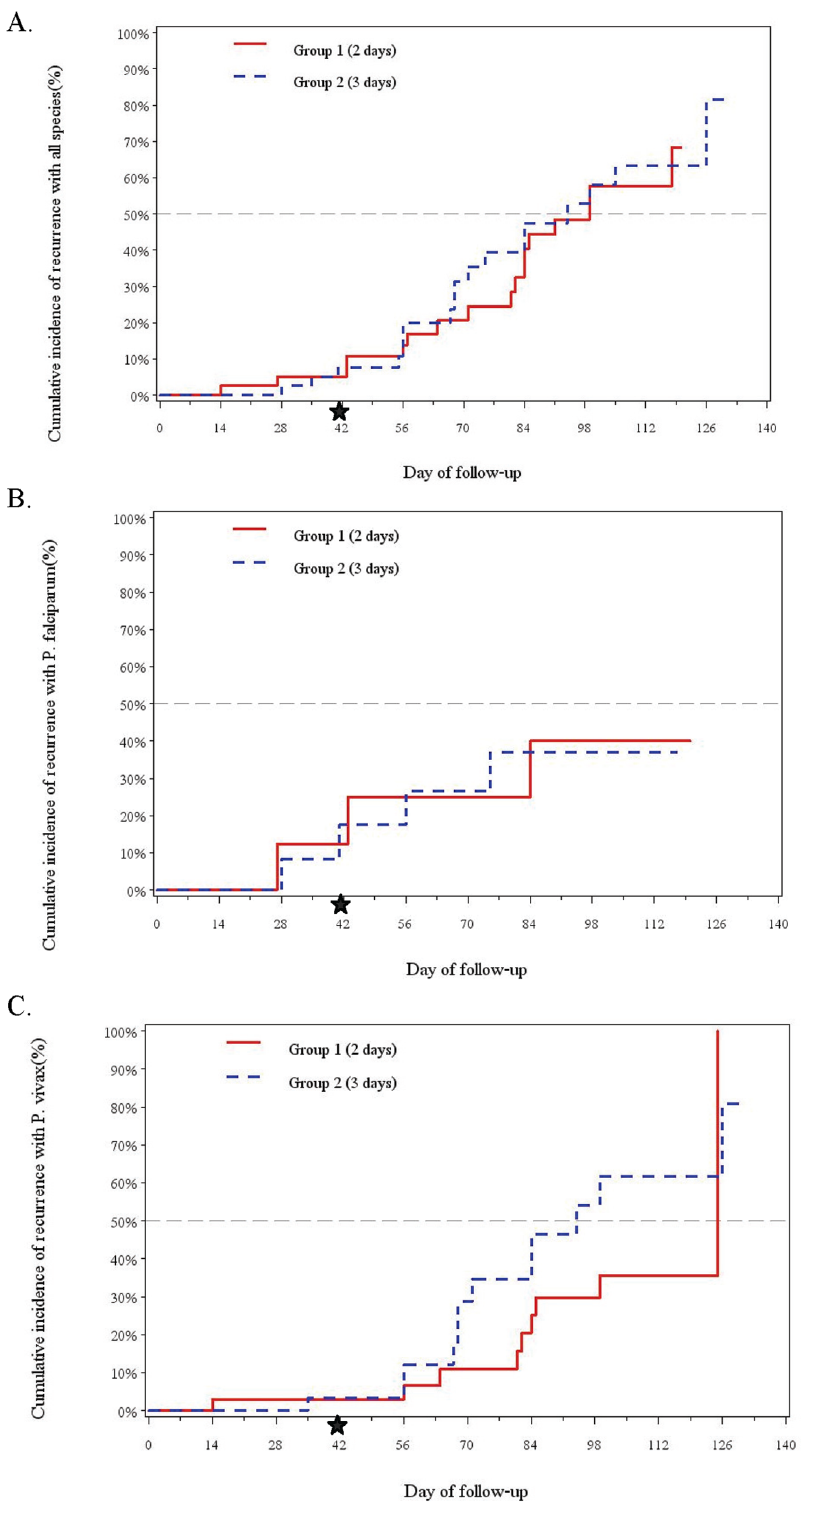
Figure 3. Cumulative incidence of recurrence by modified intention-to-treat analysis at Day 42 and study discharge. (A) No statistical difference between regimens for all-species recurrence at primary endpoint Day 42 (p=0.63) and at day of discharge (p=0.84). (B) In persons with an initial falciparum parasitemia (alone or mixed), there was no difference in true falciparum recrudescence at Day 42 (p=0.73) and at day of study discharge (p=0.91). (C) In persons with an initial vivax parasitemia (alone or mixed), there was no difference in vivax recurrence at Day 42 (0.94) and at day of study discharge (p=0.22).